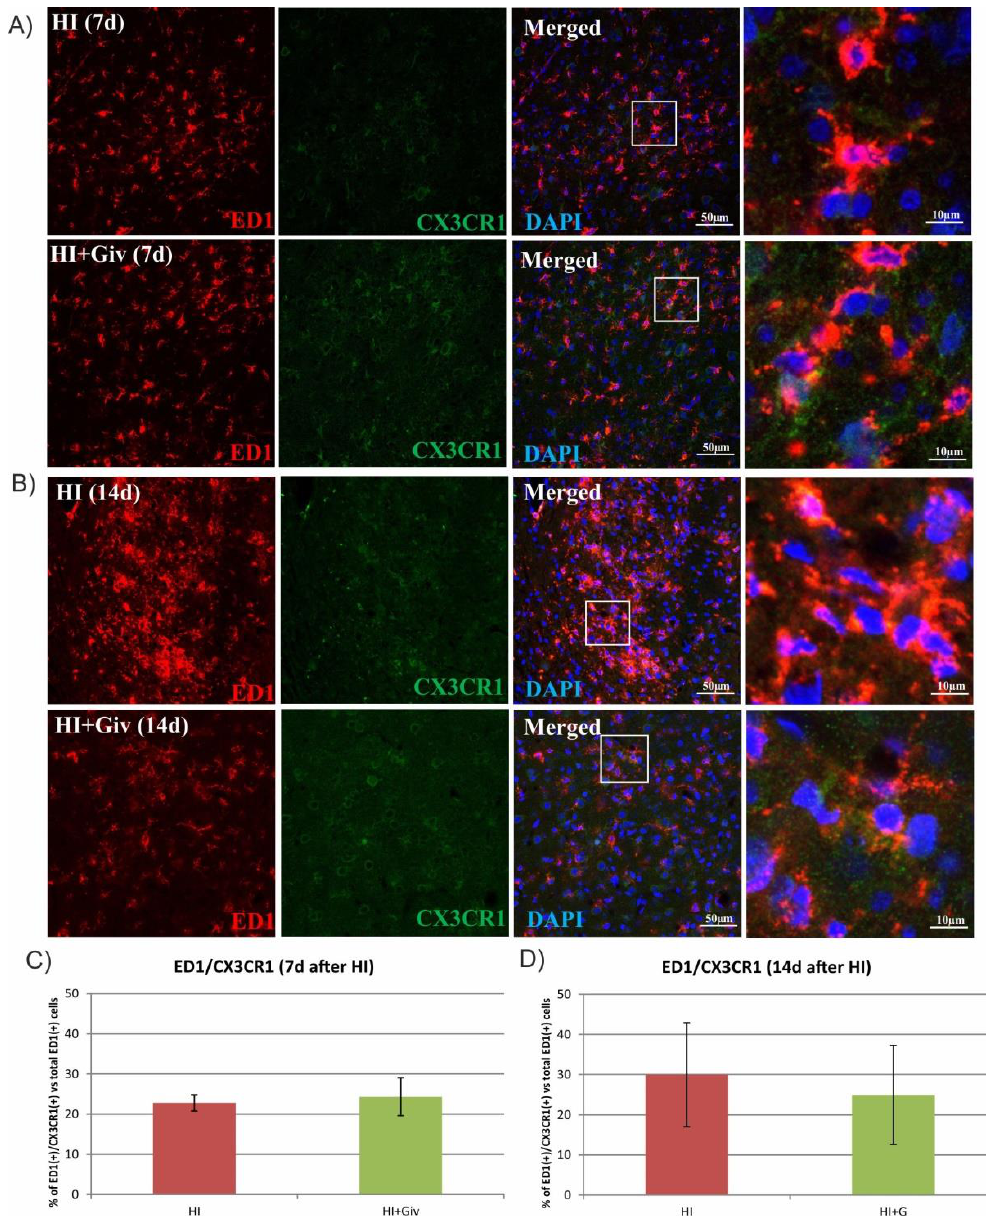
Figure 8. The effect of hypoxia-ischemia on the level of CX3CR1 localized on activated microglia. Sections from ipsilateral (hypoxic-ischemic) hemispheres 7 and 14 days after HI were stained for anti-ED1 antibody-labeled activated microglia (red) and for CX3CR1 (green) ( B ). Nuclei were labeled with DAPI (blue). Representative photomicrographs show double-labeled cells (yellow) in the cortex 7 days ( A ) and 14 days ( B ) after HI. Enlargements present areas marked in rectangles. Number of ED1/CX3CR1-positive cells quantified in the brain cortex area (0.36 mm 2 ) 7 days ( C ) and 14 days ( D ) after HI. The values are means ± SD from five animals per group. One-way ANOVA and Tukey’s test did not indicate any significant differences between the investigated groups.